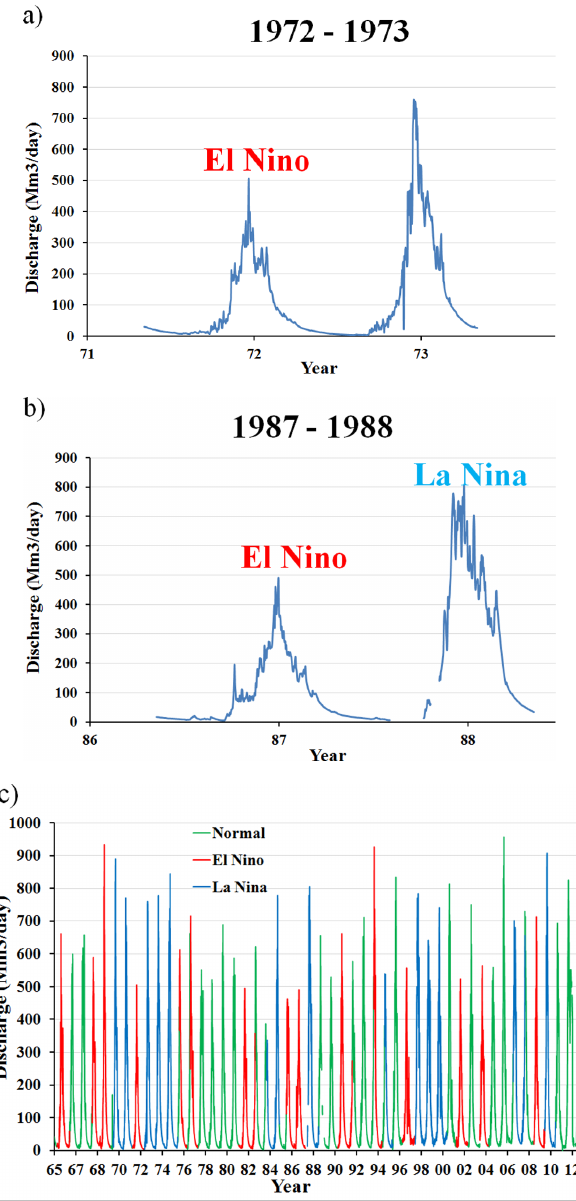
Fig. 3. The discharge of the Blue Nile at Eldiem station (1965– 2012) and its association with El Niño and La Niña years in (c) , red represents El Niño event periods, blue represents La Niña event periods, and green represents normal event periods. (a) and (b) are a zoom on some El Niño and La Niña years.